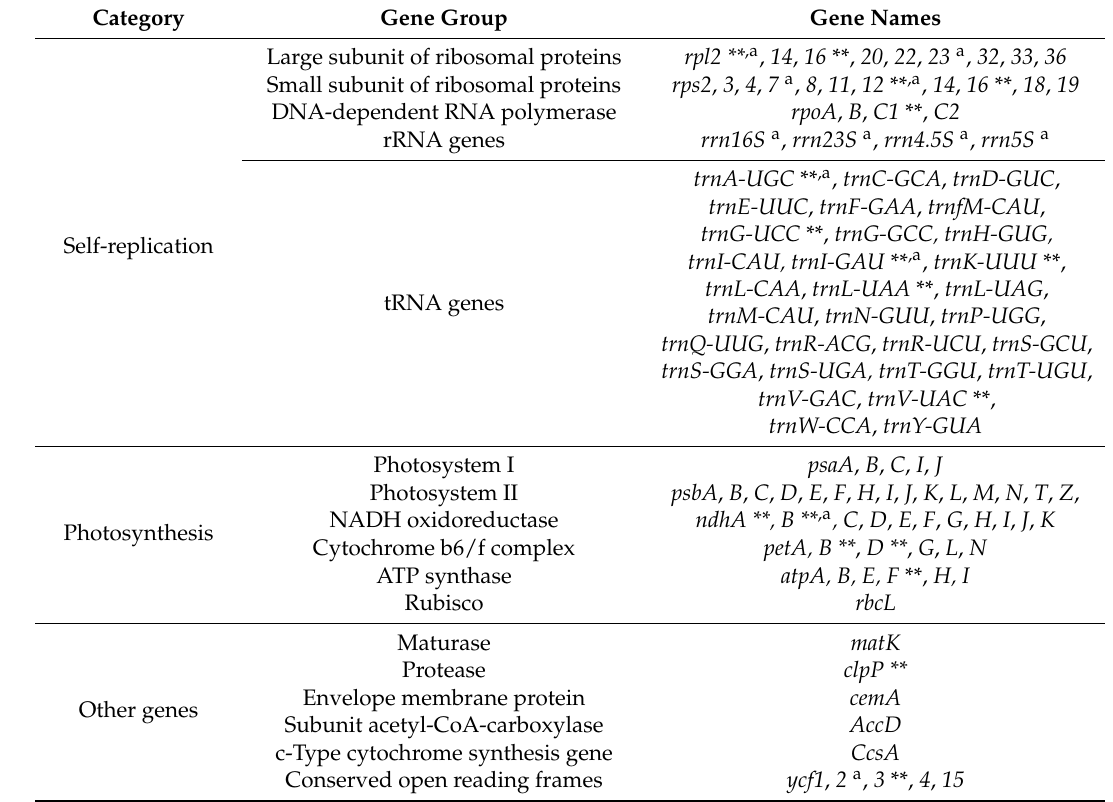
Table 2. Genes in the A. tataricus chloroplast